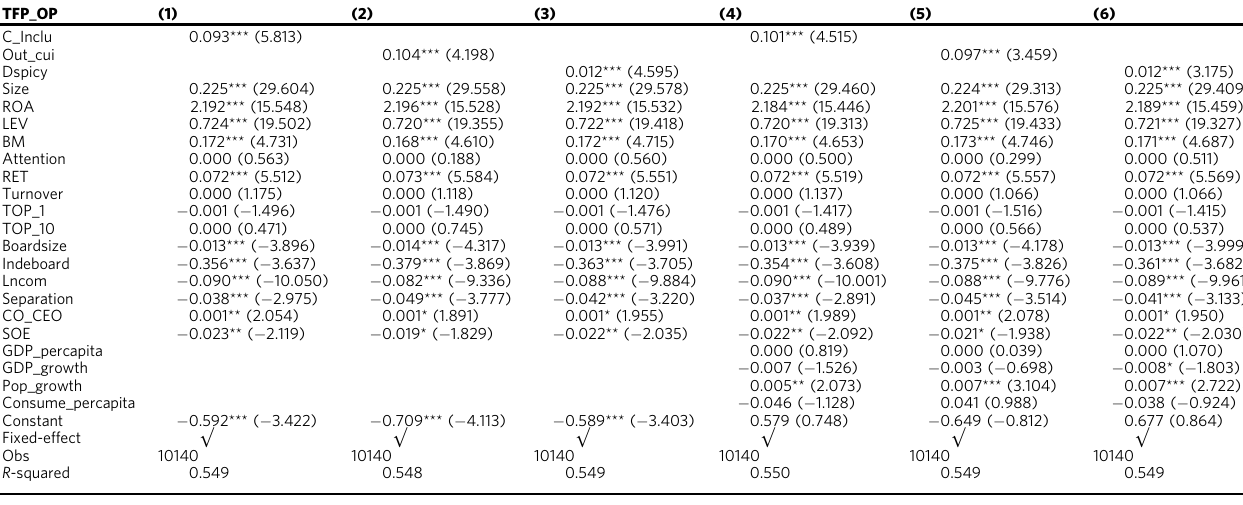
Table 7 The impact of cultural inclusion on corporate sustainability (replacement of dependent